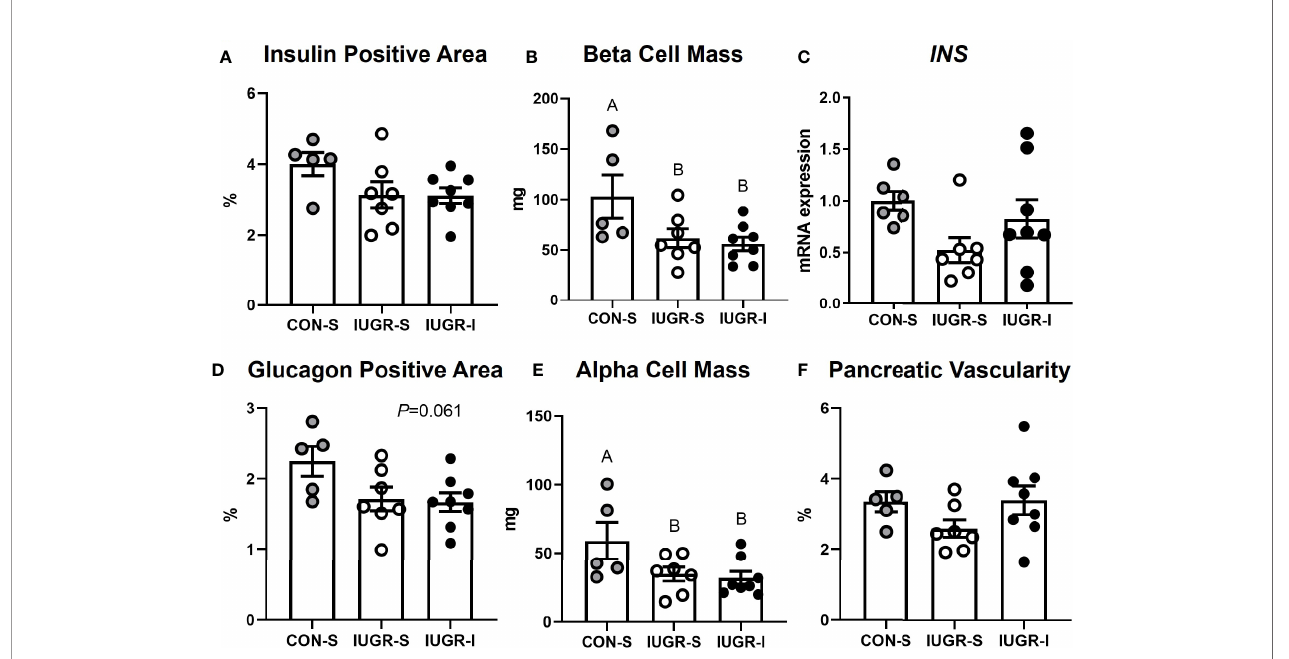
FIGURE 7 | Fetal pancreas characteristics. (A) Insulin-positive area of the pancreas as a percentage; (B) b -cell mass; (C) mRNA expression of insulin ( INS ) shown as a fold change from CON-S; (D) glucagon-positive area of the pancreas as a percentage; (E) a -cell mass; and (F) percentage of pancreatic vascularity. CON-S (grey circle, n=5), IUGR-S (white circle, n=7), and IUGR-I (black circle, n=8). Values are mean ± SEM. Statistical signi fi cance was designated by different alphabetical letters at P ≤ 0.05 by one-way ANOVA or or Kruskal-Wallis Test, and Fisher ’ s least signi fi cant difference post hoc